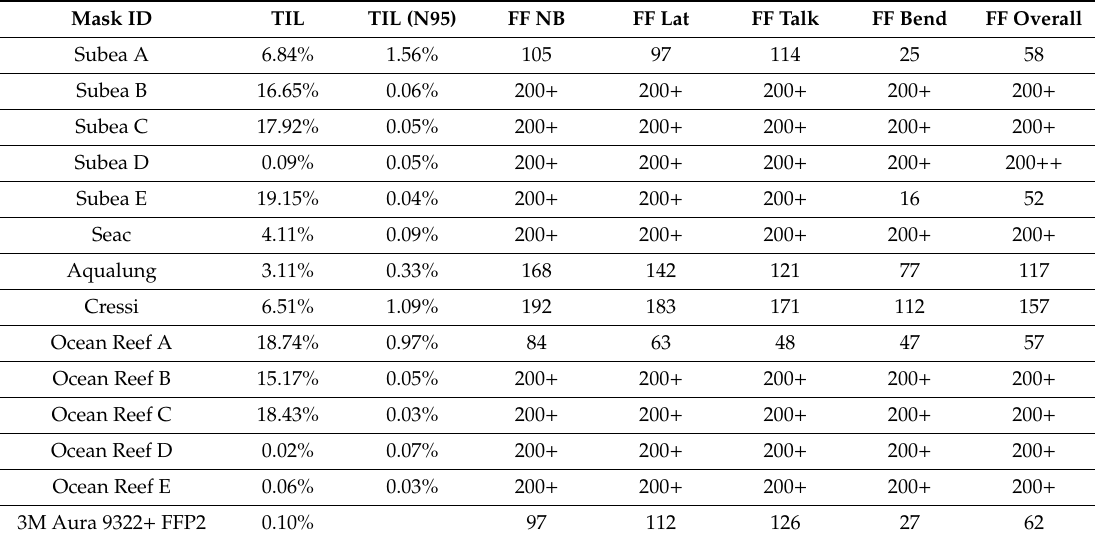
Table 2. Protection levels as measured by Total Inward Leakage (TIL) and Fit